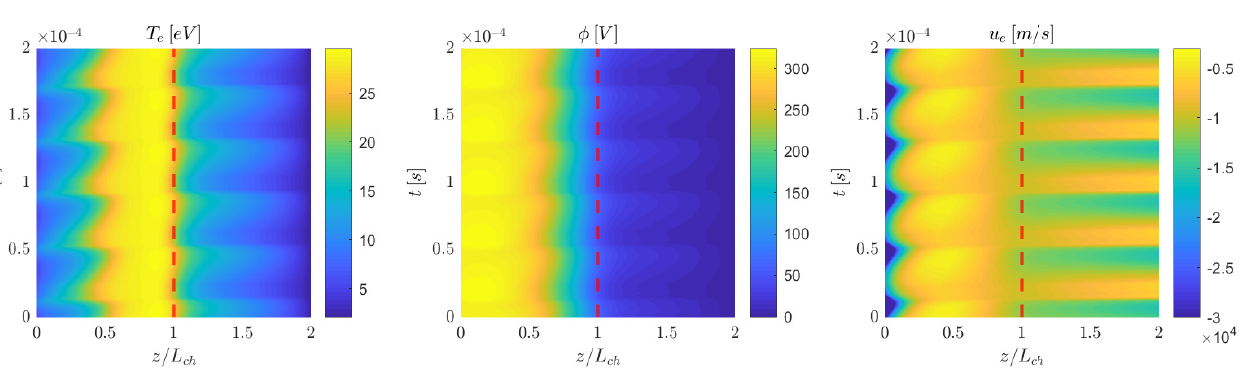
Figure 7. Space–time simulated plasma properties: ( left ) plasma density, ( middle ) neutral density, ( right ) ion velocity. The red dashed line indicates the channel exit.